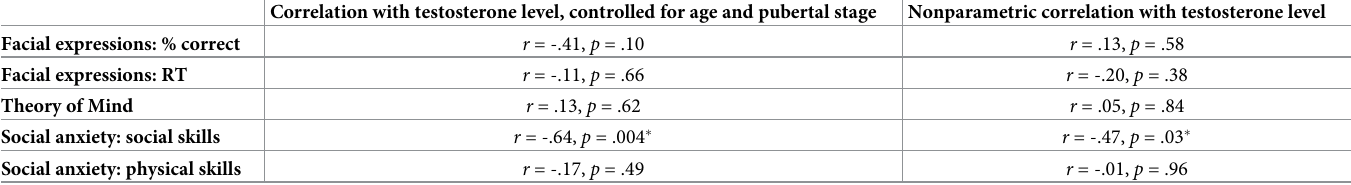
Table 2. Correlations between levels of salivary testosterone and social cognition and social anxiety within the XXY group ( n = 20). Correlation with testosterone level, controlled for age and pubertal stage Nonparametric correlation with testosterone